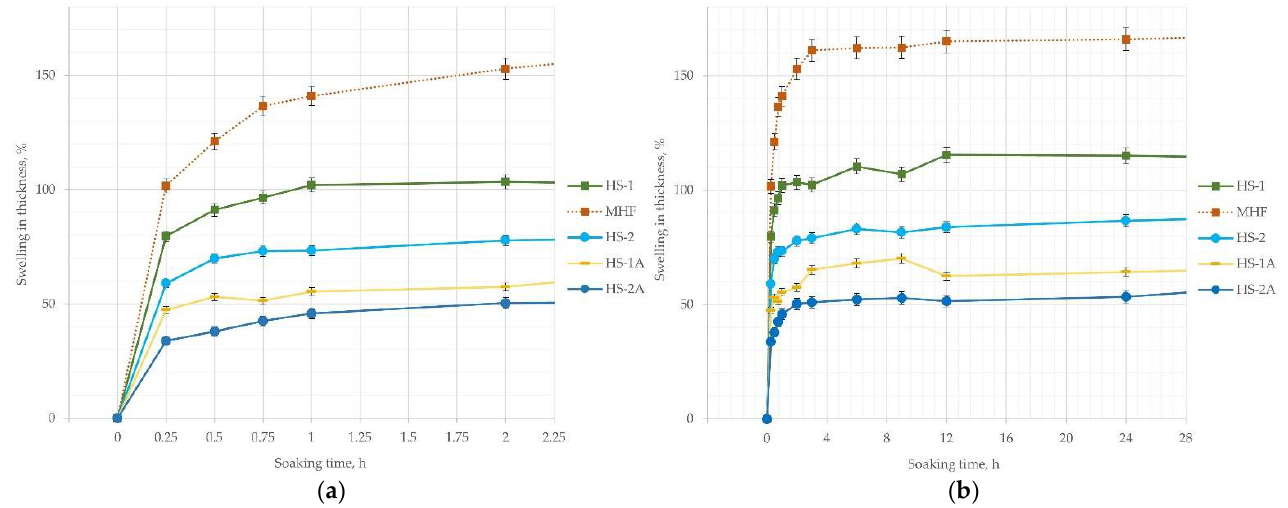
Figure 7. Water absorption—swelling in thickness of hemp board samples: ( a ) thickness swelling for 2 h; ( b ) thickness swelling for 24 h.